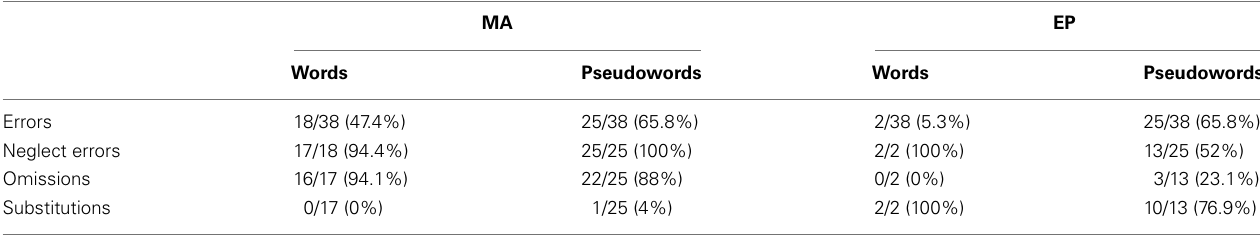
Table 2 | Neglect dyslexia assessment (Vallar et al., 1996) for MA and